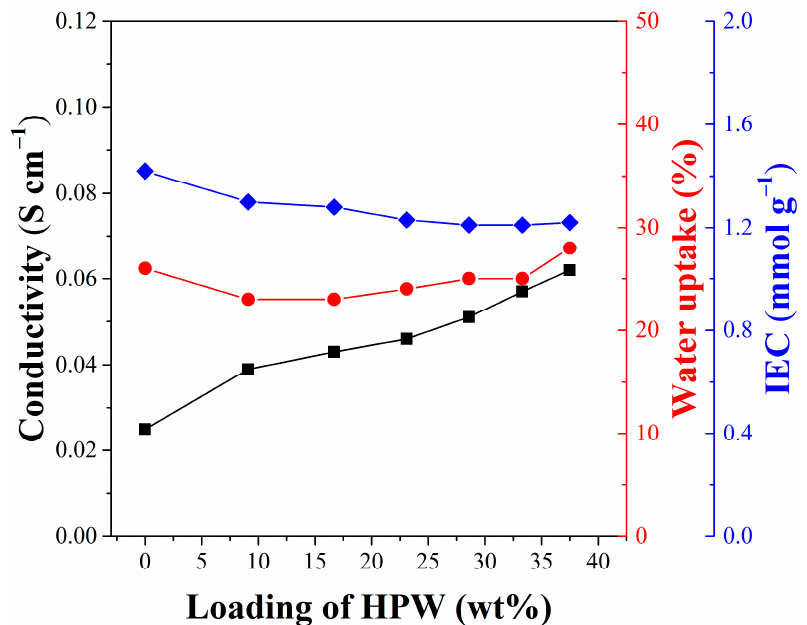
Figure 5. Proton conductivity, water uptake and IEC of SPEEK/DGO/DHNTs/HPW composite membranes.